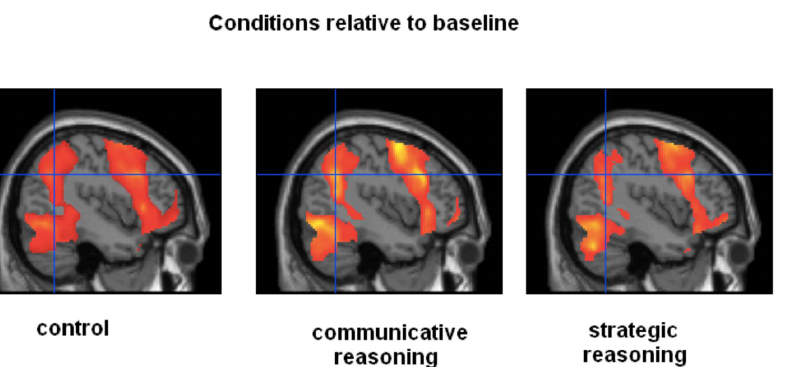
Figure 2. Statistical maps for conditions relative to resting baseline at MNI coordinates 2 42 2 56 32. Note increased BOLD responses for communicative reasoning and less activation during strategic